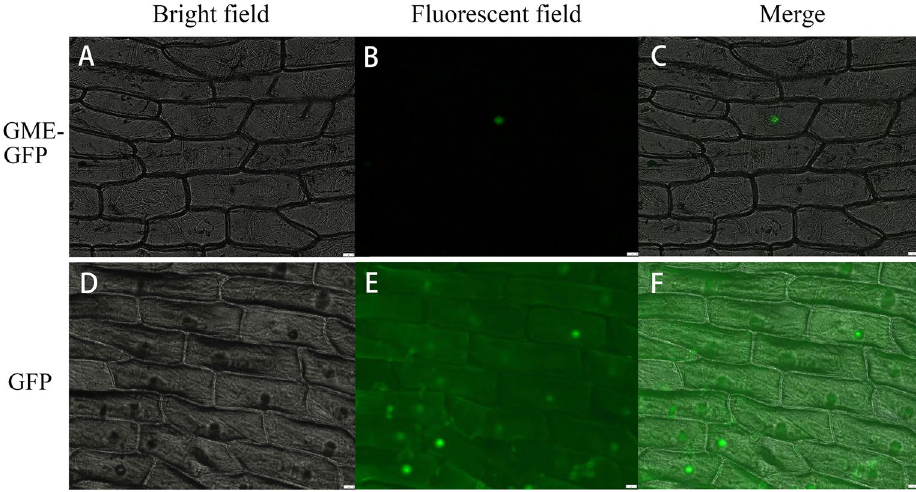
Figure 3. Subcellular localization of GME. GFP-tagged GME protein was transiently expressed in onion epidermal cells. ( A – GME-GFP; ( D – F ) GFP. Left to right: bright field, fluorescent field, and merged image.